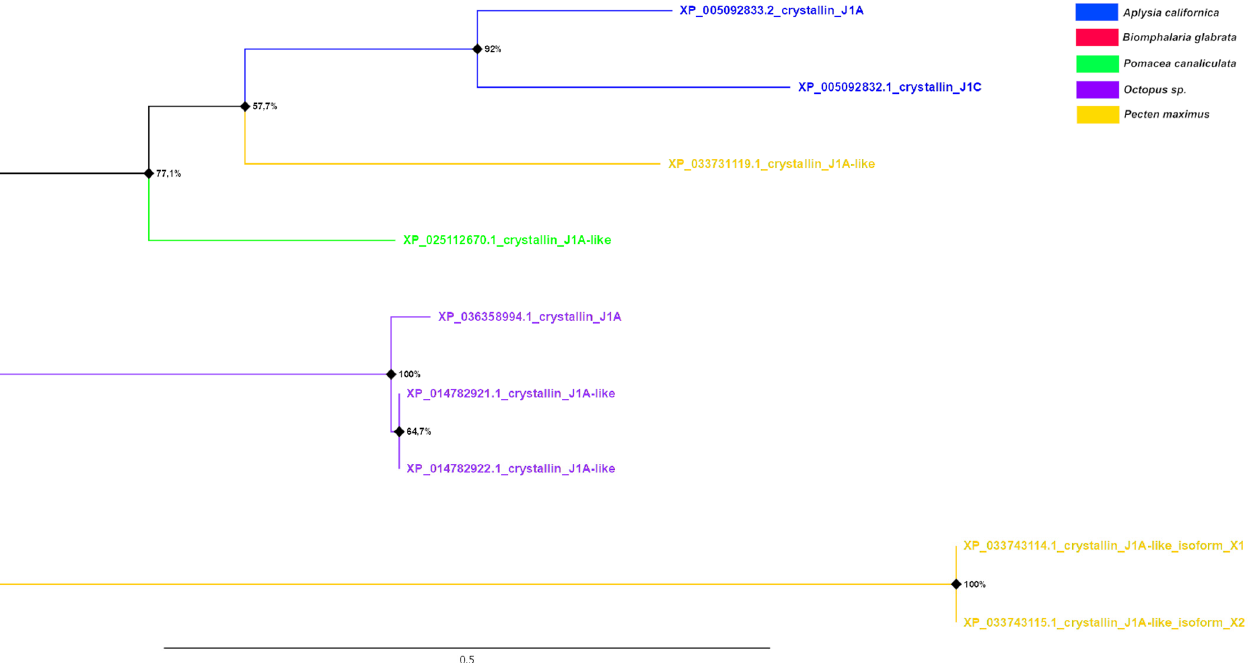
13 of 27 Figure 5. Phylogenetic tree of α -crystallins of molluscs.